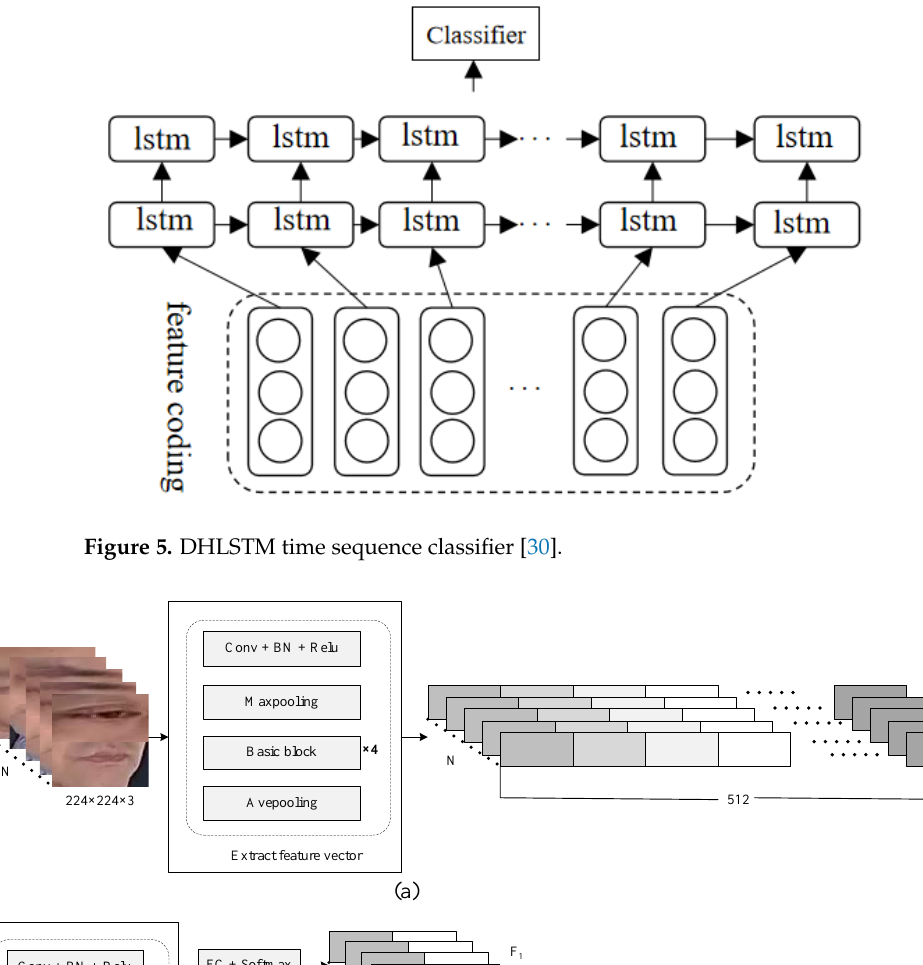
Figure 5. DHLSTM time sequence classifier [30].